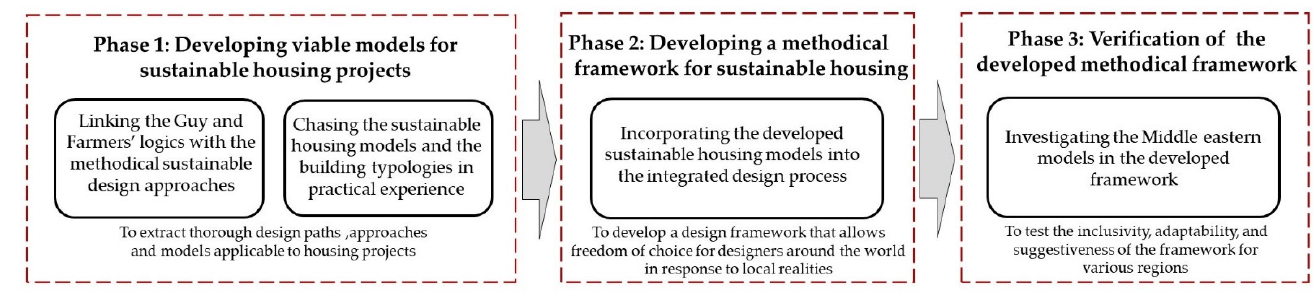
Figure 4. Phases and steps of research implemented in this study.